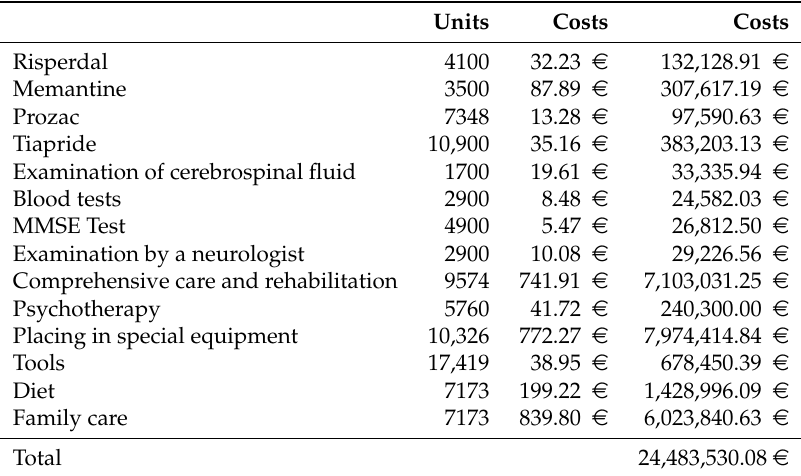
Table 7. ABC: check-table of all costs.